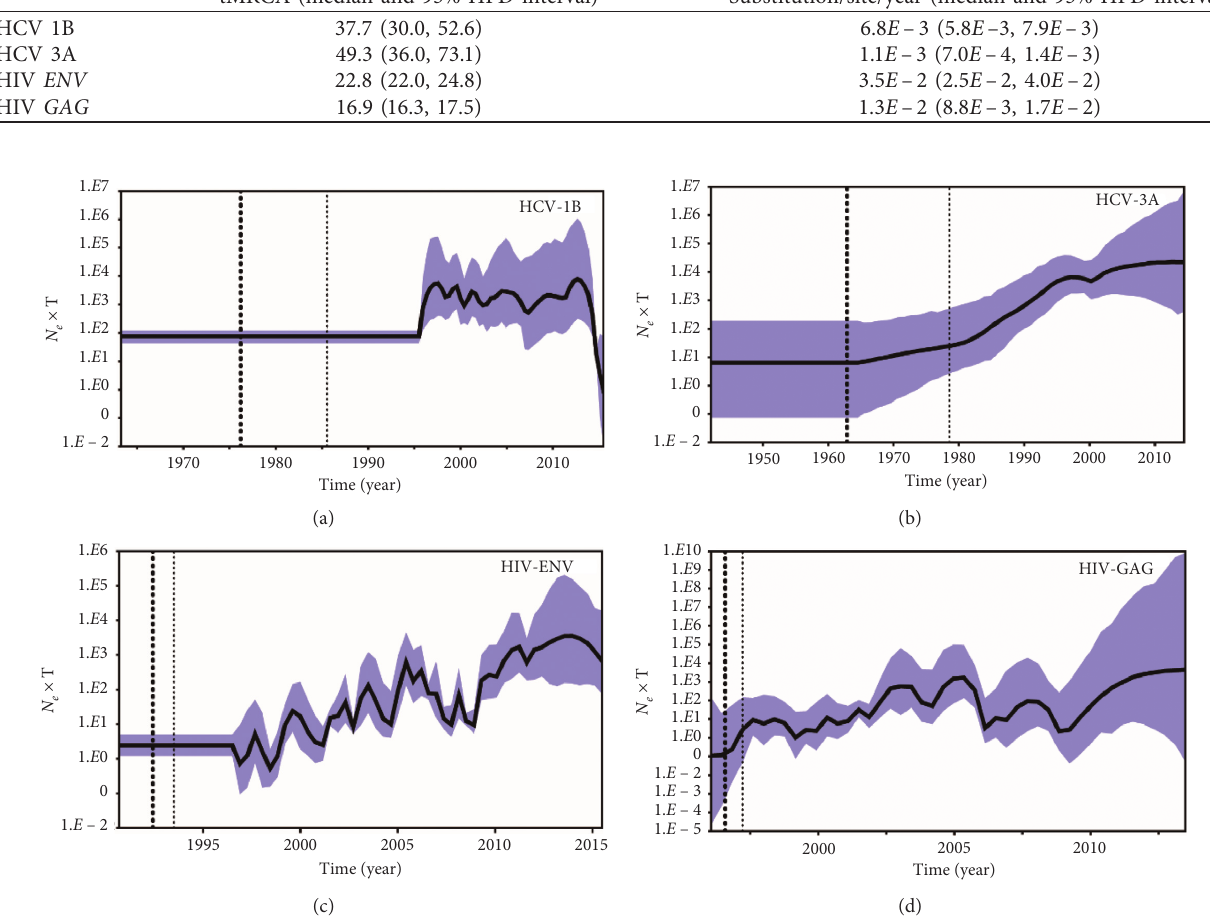
Figure 6: Population dynamics of the expansion of HCV genotypes 1B and 3A (top left and right panel, respectively) (NS5B) and HIV-1 subtype A ( env and gag : bottom left and right panel, respectively). The population dynamics was analysed by Bayesian MCMC inference method with a SkyGrid demographic reconstruction model in BEAST. The vertical axis shows the effective number of infections ( N e ) multiplied by mean viral generation time ( t ). The solid line and shaded region represent the median and 95% credibility interval of N e t through